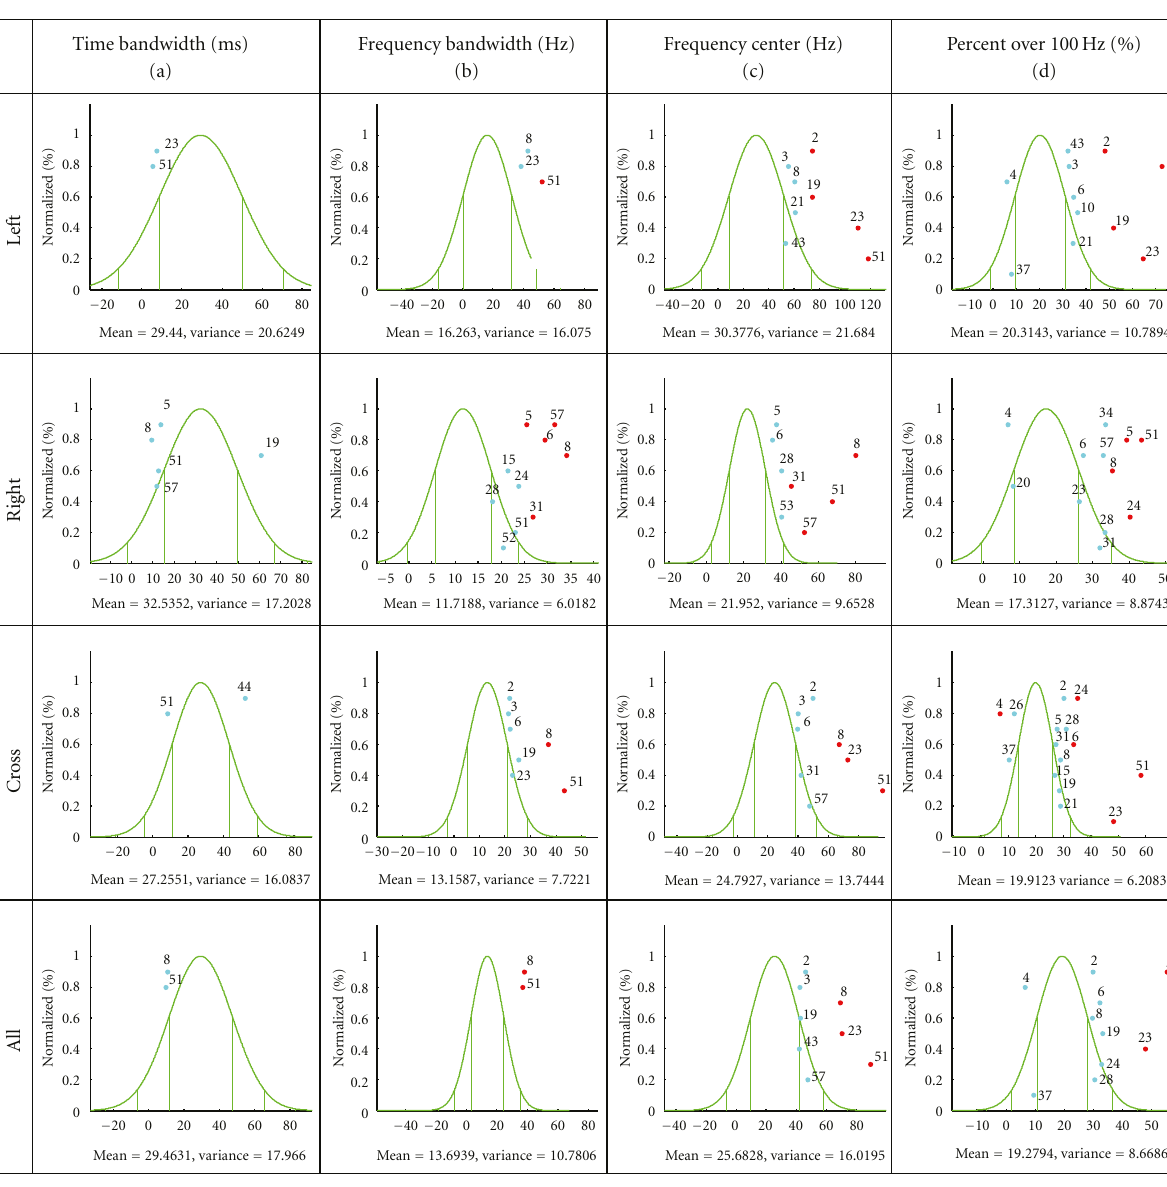
Figure 12: Cross-foot Gaussian distribution functions based on 10 control cases for (a) time bandwidth, (b) frequency bandwidth, (c) frequency center, and (d) percent energy above 100 Hz with outlying subjects marked in blue (1 σ outside) and red (2 σ